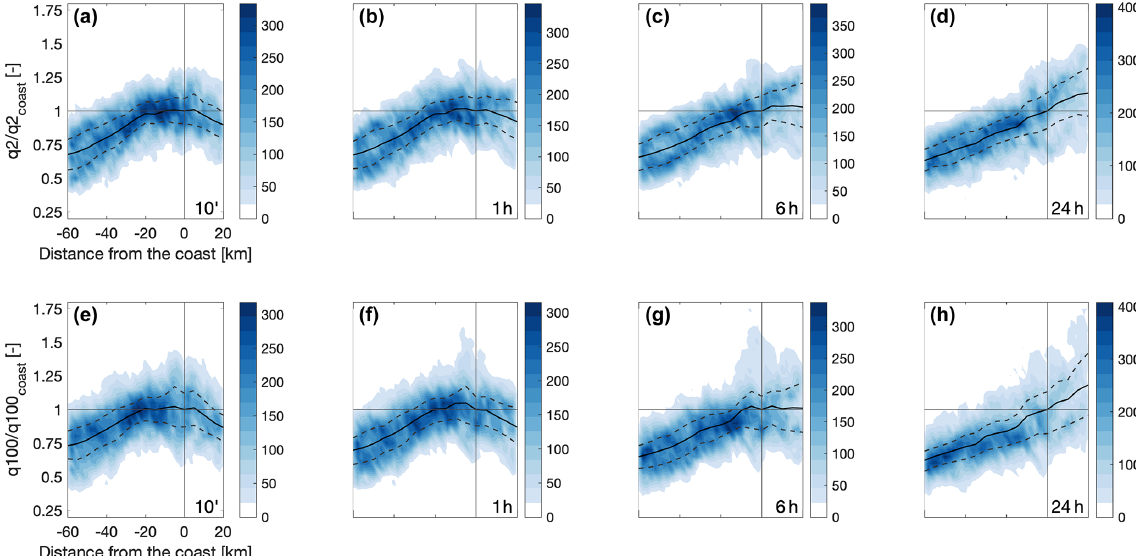
Figure 4. Density plots of the 2-year (a–d) and 100-year return levels (e–h) as a function of the distance from the coastline (see dashed lines in Fig. 1) for durations of 10min and 1, 6, and 24h. Color shading represents the number of pixels in bins of 2km by 0.05. Negative distances represent offshore areas. The median and 25th–75th quantiles of the distribution along 5km bins are shown as solid black lines and dashed black lines, respectively. In order to have comparable values across durations, return levels are normalized over the median value at the